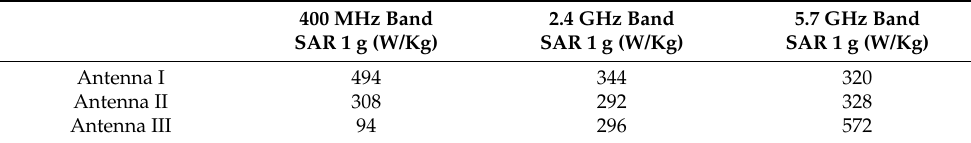
Table 2. SAR in one gram of tissue by 1 W stimulation.